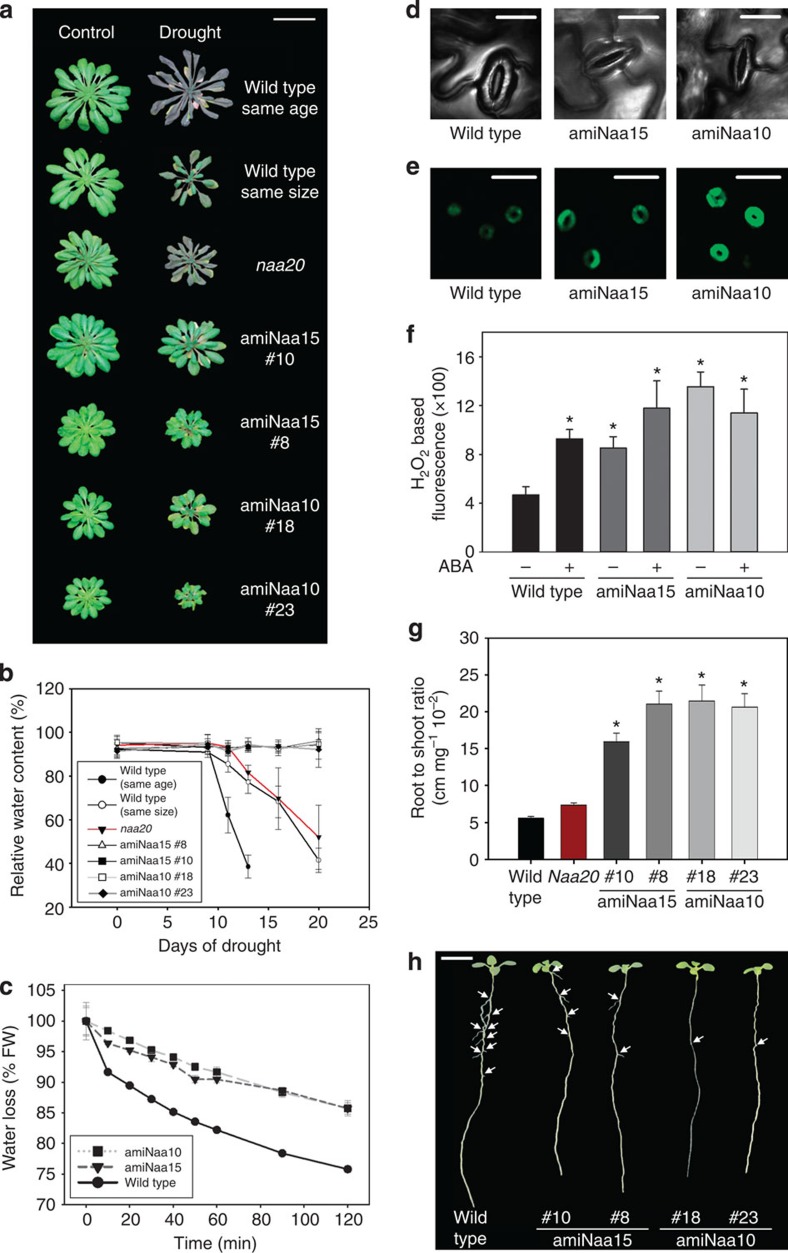
NatA-depleted Arabidopsis plants display drought tolerance.Wild-type (same age) and NatA-depleted plants were grown for 42 days on soil under short-day conditions and subsequently challenged with drought for 20 days. Twety-eight-day-old wild-type plants (same size) served as an additional control to test the impact of developmental stage on the tolerance against drought. (a) Growth phenotype of wild-type and NatA-depleted plants grown under control conditions or drought stress for 20 days (Scale bar, 4 cm). (b) RWC in leaves of wild-type, amiNaa10 and amiNaa15 plants during application of drought stress. Data are represented as mean±s.d. (N=4). (c) Transpiration of leaves from 6-week-old wild-type and NatA-depleted plants. Data are represented as mean±s.d. (N=3). (d) Top view on single stomata from wild-type and NatA-depleted plants (Scale bar, 20 μm). (e) Fluorescent staining of hydrogen peroxide in guard cells of wild-type and NatA-depleted plants (Scale bar, 40 μm). (f) Quantification of hydrogen peroxide-dependent fluorescence by confocal laser scanning microscopy in guard cells of wild type and NatA depleted in absence or presence of 50 μM ABA. Wild type and NatA depleted were grown on soil under short-day condition with regular water supply for 6 weeks before analysis. Data are represented as mean±s.e. Asterisks indicate significant differences to wild type. (P<0.05, N=10–80, Student's t-test) (g) Root-to-shoot ratio of wild-type, naa20 and NatA-depleted plants grown hydroponically on ½ Hoagland medium for 6 weeks under short-day conditions. Asterisks indicate significant differences to wild type determined by Student's t-test. Data are represented as mean±s.d. (P<0.05, N=30–35), Student's t-test). (h) Root phenotype of 2-week-old wild-type and NatA-depleted plants grown under short-day conditions on solid ½ MS-medium (Scale bar, 0.5 cm). Arrows indicate lateral roots.